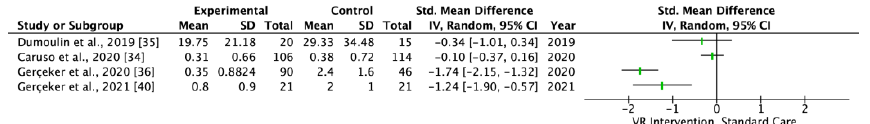
8 of 14 Figure 3. Comparison of VR treatment and standard care, pain (WBS). SD: standard deviation; 95% CI: 95% confidence interval; green square: mean difference; black rhombus: pooled effect. Two studies, with 240 patients overall, were analyzed for pain score after a needle- related procedure. As the outcome measures in the included studies were performed using the Faces Pain Scale–Revised (FPS-R), the analysis was performed using MD with a fixed effect model. No significant difference was found between VR Treatment and standard care for pain score (MD = − 0.19; 95% CI − 0.58, 0.20; I 2 = 0%) (Figure 4). Figure 4. Comparison of VR treatment and standard care, pain (FPS-R). SD: standard deviation; 95% CI: 95% confidence interval; green square: mean difference; black rhombus: pooled effect.